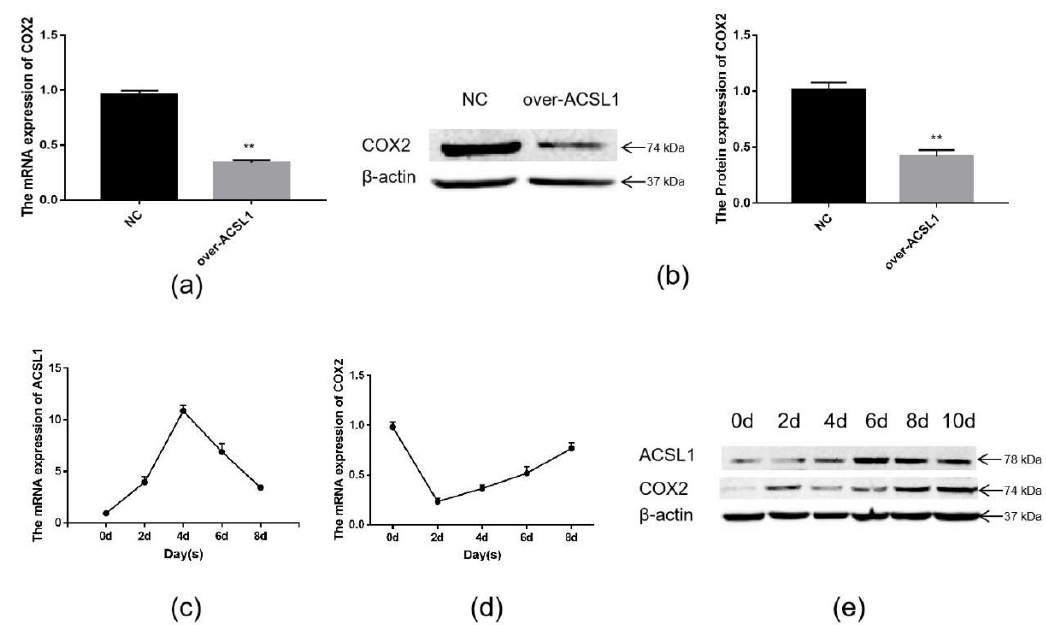
Figure 5. The expression of ACSL1 and COX2: ( a ) ( b ) the mRNA and protein expression of COX2 in adipocytes with overexpression of the ACSL1 gene on day 8 after differentiation; ( c ) the mRNA expression of the ACSL1 in different stages of differentiation; ( d ) the mRNA expression of the COX2 gene in different stages of differentiation; ( e ) the protein expression of the ACSL1 and COX2 genes in different stages of differentiation; (* p < 0.05, ** p < 0.01). NC: Adipocytes transfected with the pcDNA3.1(+) vector as control. Over-ACSL1: Adipocytes transfected with the pcDNA3.1(+) vector with ACSL1 CDS.